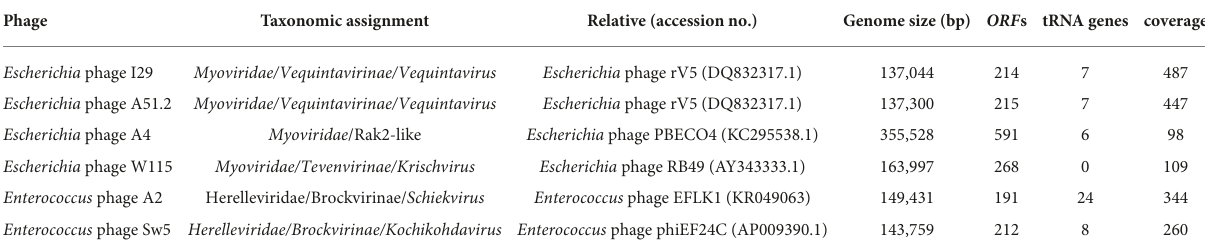
TABLE 2 Summary of genomic features of phages used in this